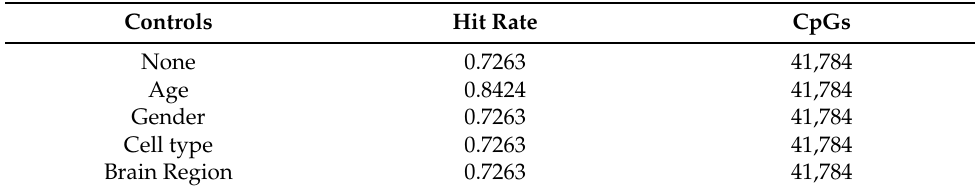
Table 7. HR of SVM for Alzheimer classification (versus control patients), using all CpGs with p -values < 0.05 (41,784) and controlling for different factors, such as age, gender, cell type, or brain region (GSE 66351 test data).